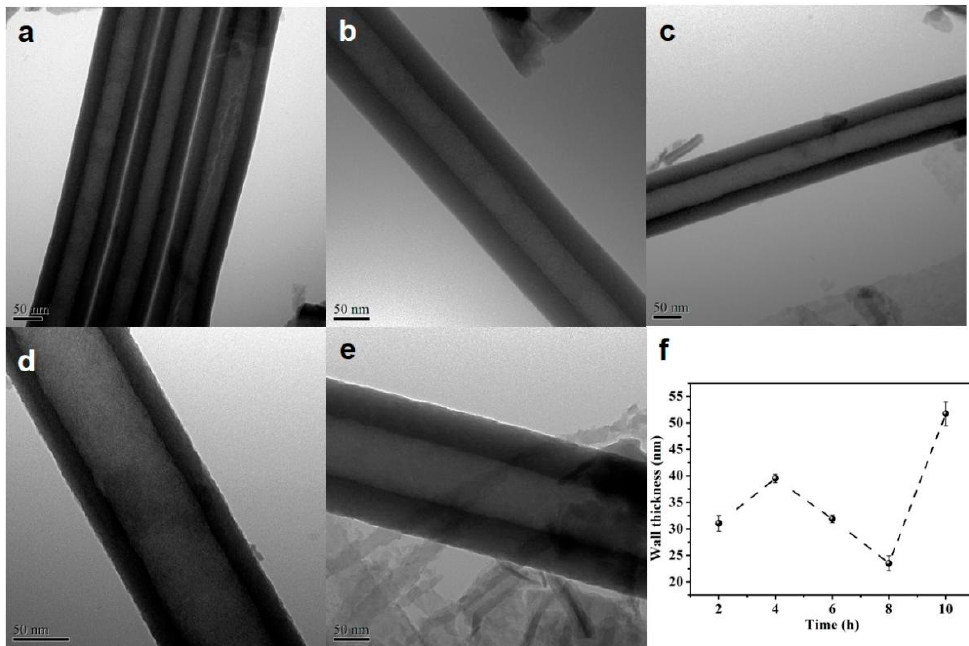
Figure 4. ( a – e ) TEM images of the HEO nanotubes formed under 60 V in the ethylene glycol solution containing 0.1 mol/L NH 4 F and 10 vol.% of water after different anodization times, ( a ) 2 h, ( b ) 4 h, ( c ) 6 h, ( d ) 8 h and ( e ) 10 h; ( f ) Changes in nanotube wall thickness with anodization time.